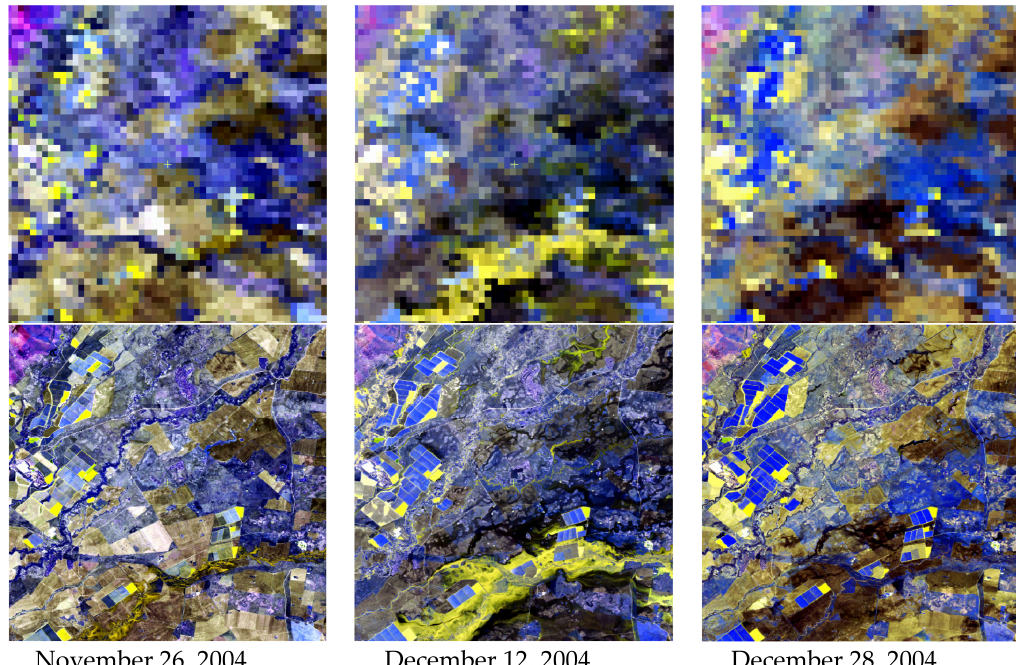
Figure 2. Landsat-5 TM surface reflectance image acquired on December 12, 2004 for the Lower Gwydir Catchment study site ( left ) located in northern New South Wales, Australia and the test area for this study ( right ).